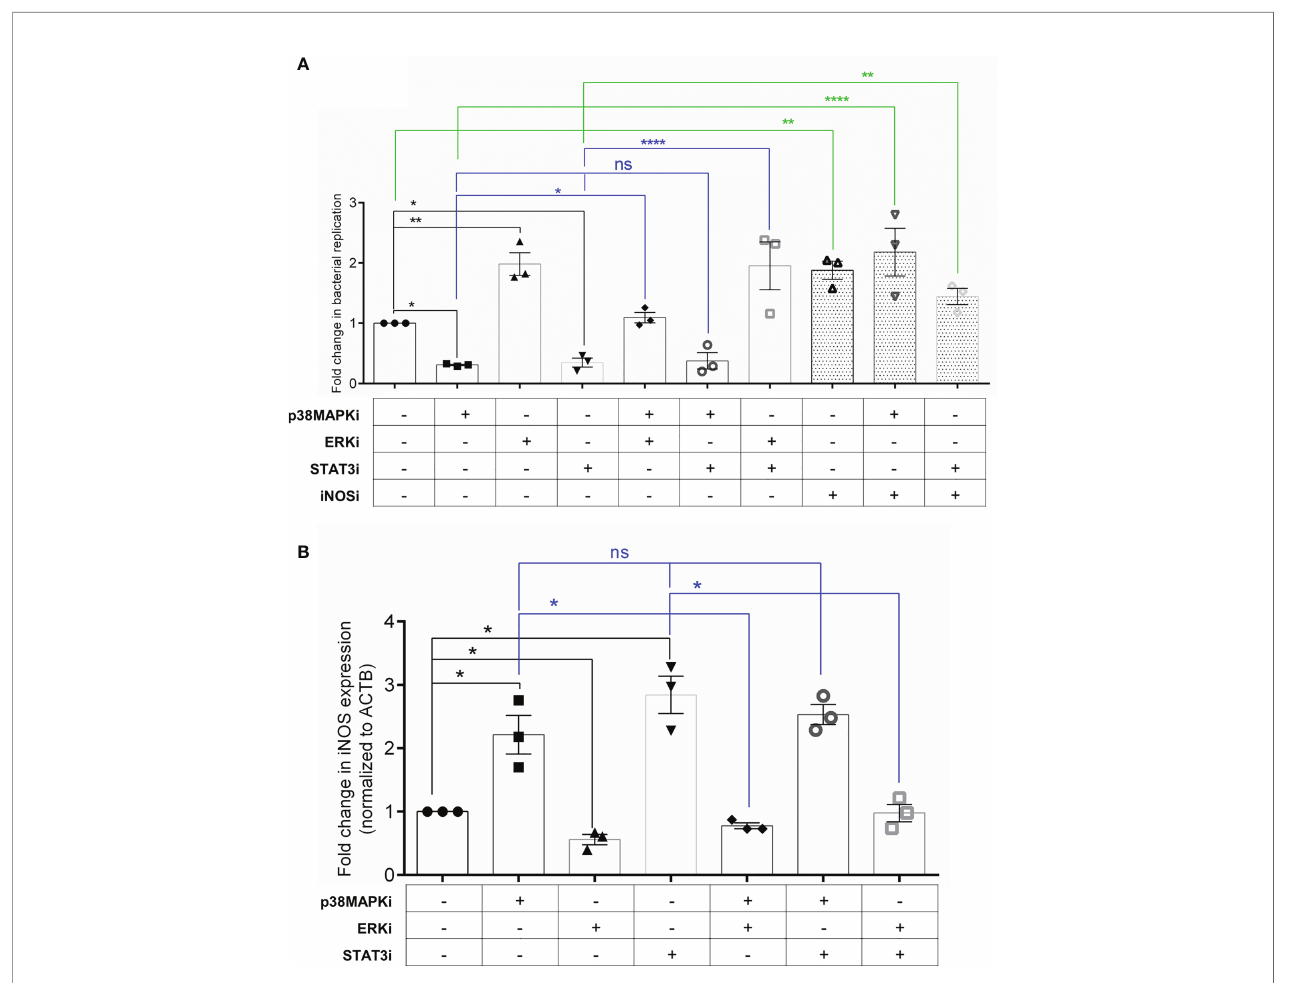
FIGURE 4 | Crosstalk between p38 MAPK, ERK and STAT3 can regulate iNOS levels and infection in senescent cells. (A) Fold change in bacterial replication (relative to vehicle control) at 16h in senescent HeLa cells treated with inhibitors as indicated. iNOSi indicates cells treated with iNOS inhibitor, Aminoguanidine. (B) iNOS gene expression analysis by qRT-PCR in senescent HeLa cells treated with inhibitors as indicated. Values were normalized to b -actin and then wrt vehicle- treated cells to determine fold changes. The data represents mean ± SEM from atleast three independent experiments. Statistical signi fi cance of differences was analysed by Independent t-test, ns, non signi fi cant, * P ≤ 0.05, ** P ≤ 0.01, **** P ≤